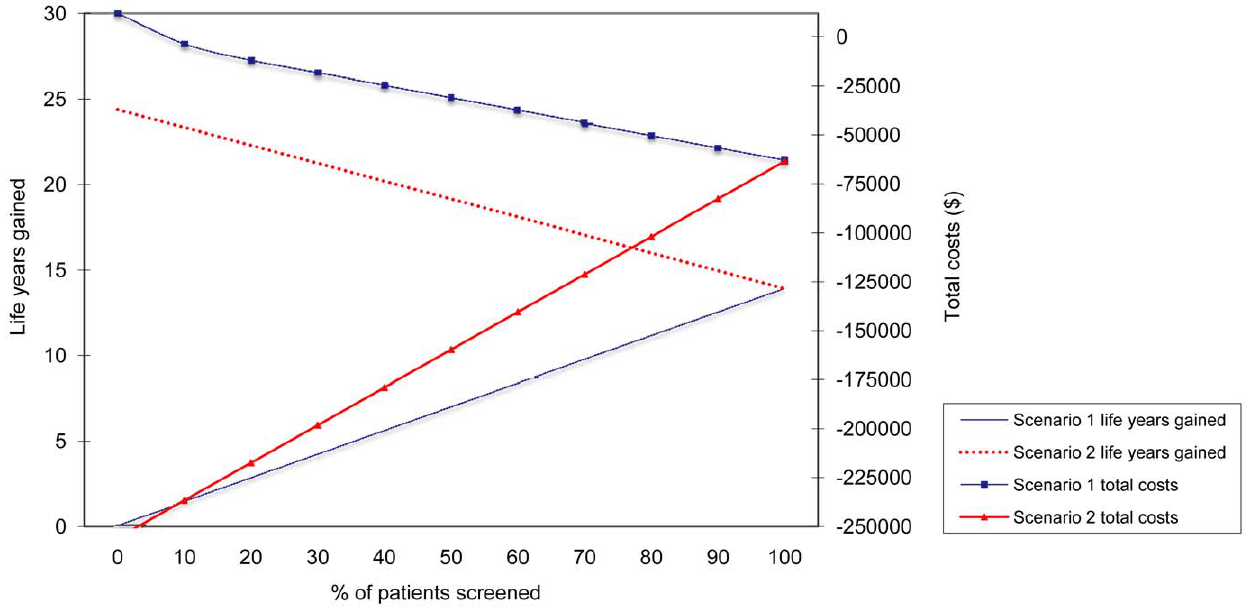
Figure 1. Effect of suboptimal adherence to preoperative S.aureus screening on total costs and life years gained (discounted) per 1000 patients for scenario 1 (only identified S.aureus carriers are treated) and scenario 2 (identified S.aureus carriers and non- screened patients are treated). Note the negative costs on the y-axis representing cost-savings. doi:10.1371/journal.pone.0014815.g001 savings. The benefits in life years gained and costs saved must be balanced against the risks for selection of mupirocin and/or